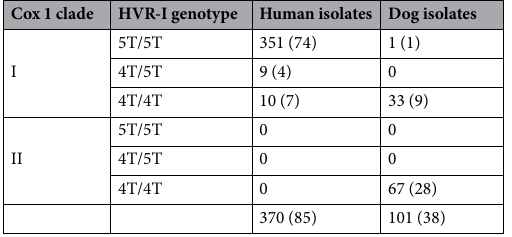
Table 1. 18S rDNA hyper-variable region I (HVR-I) genotypes of Strongyloides worms isolated from humans and dogs. The number of worms (outside the brackets) with respective genotypes are shown. Numbers inside the brackets indicate the number of hosts from which worms with respective genotypes were